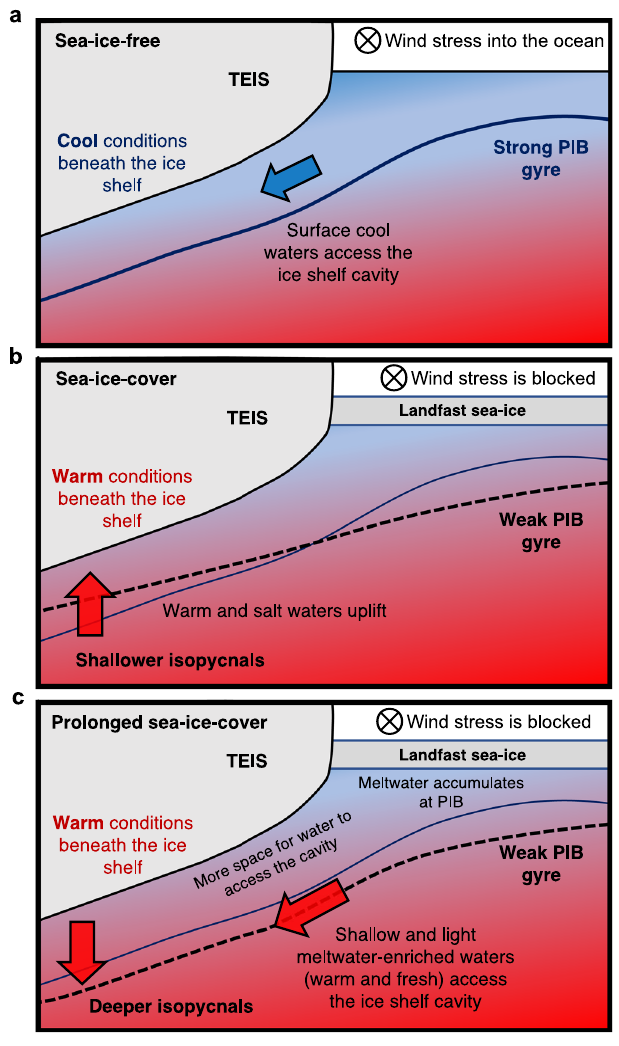
Fig. 8 | Schematic of the processes identi fi ed. a During sea-ice-free conditions, the ThwaitesEasternIce Shelf(TEIS)cavity is fi lled with shallow cold waters due to thestrengtheningofthePineIslandBay(PIB)gyre,asdepictedbythesteepeningof the isopycnal (solid line). The density fi eld is shallow in the middle of the gyre and deepens to beneath the TEIS front. b During sea-ice-covered periods, the wind- stress is damped and the isopycnals relax, which characterises a weakening of the gyre(dashedline).UndertheTEIS,theisopycnalsuplift,whichbringswarmandsalt waters close to the ice base, creating a warm condition beneath the ice shelf. c During prolonged sea-ice-covered periods, the isopycnals fl atten (yellow dashed line),thegyreweaken,andmeltwaterisaccumulatedinthePIBarea,whichreduces the density fi eld. The isopycnals near and beneath TEIS deepen, which open space for higher volume of shallow and light meltwater-enriched waters to fl ood the upper layers of the ice shelf cavity, leading to a warm condition. In all panels the isopycnalofsea-ice-freeconditionsisdepictedforreference.Thecolourillustrates the temperature fi eld, with red (blue) colour representing warm (cold)